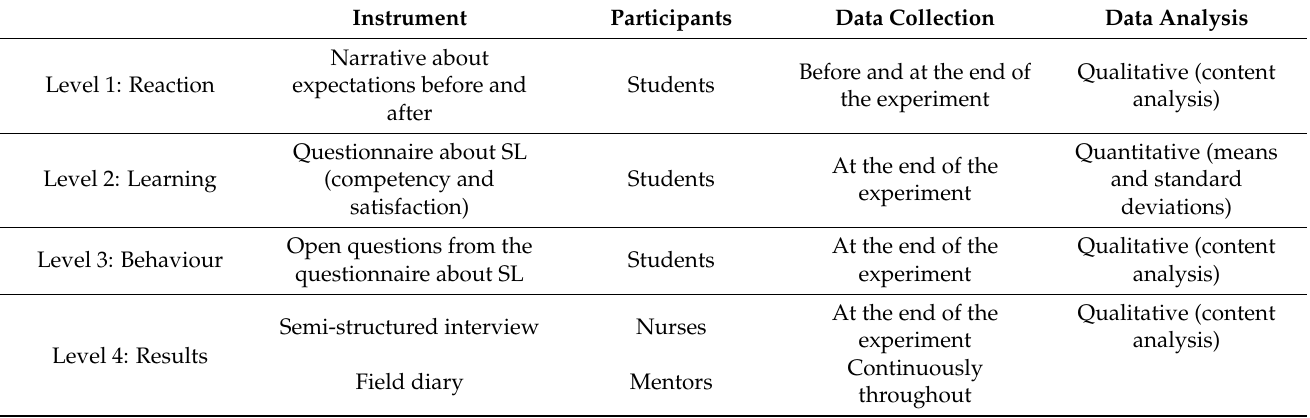
Table 1. Summary of the instruments, participants and data collection following the Kirkpatrick